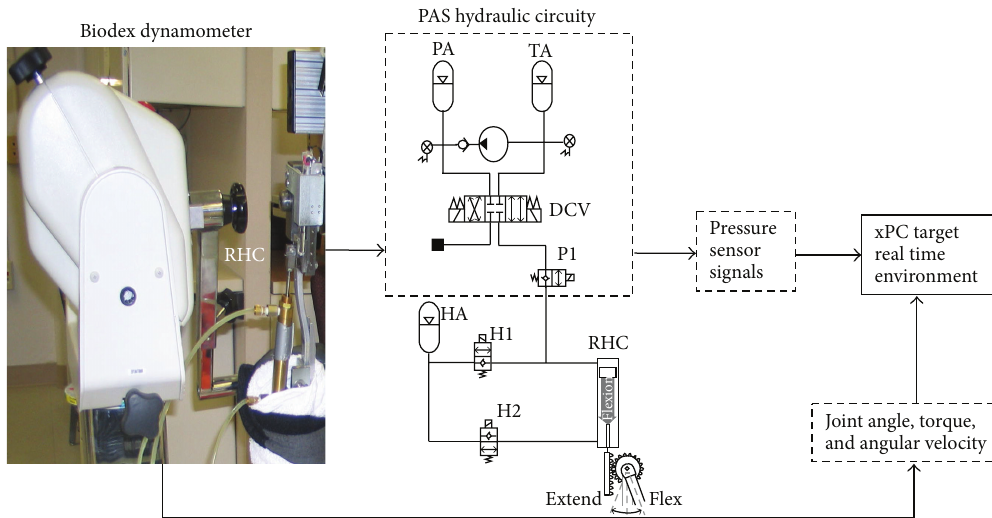
Figure 2: PAS bench testing setup. The PAS hydraulic circuitry is connected to the rotary actuator consisting of right hip cylinder (RHC) connected between the exoskeleton upright and rack and pinion transmission to transmit torque. The upright is attached to a Biodex dynamometer to measure flexion torque. Pressure, torque, angle, and angular velocity data are read into an xPC Simulink real time environment.